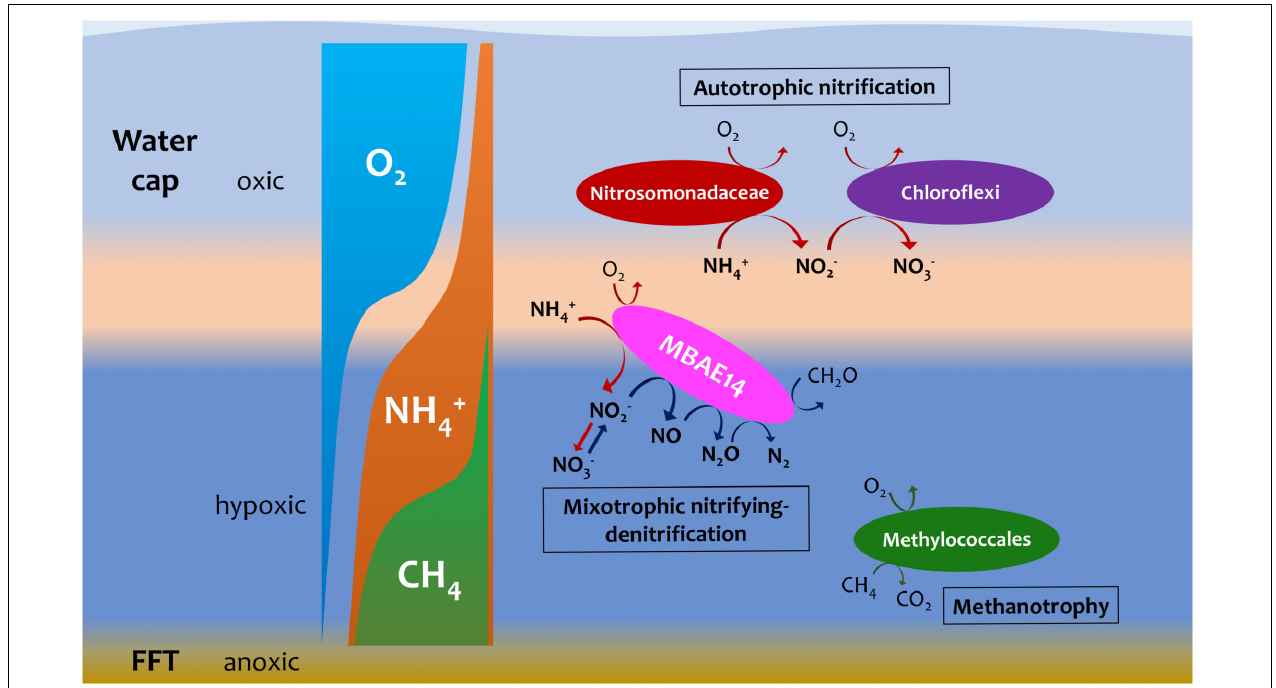
FIGURE 7 | Hypothetic, schematic model summarizing nitrogen and methane biogeochemistry in the summer stratified Base Mine Lake water column (August 2015 and 2016 respectively). A novel gammaproteobacterial group MBAE14 (proposed mixotrophic nitrifying-denitrifier), thrives at the oxic/hypoxic zones of Base Mine Lake water cap separated from autotrophic aerobic nitrifiers (Nitrosomonadaceae and nitrite-oxidizing Chloroflexi). The metalimnetic oxygen-ammonia transition zone (light orange) is suggested as the hotspot for aerobic nitrification by different nitrifiers, while methanotrophy (conducted by Methylococcales) primarily occurs in the hypoxic lower hypolimnetic zones where elevated concentrations of dissolved methane were